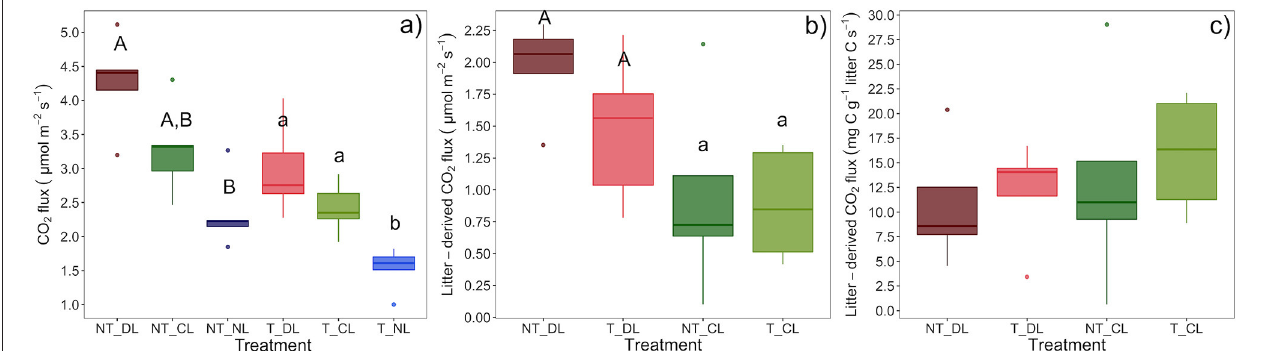
FIGURE 8 | (a) Mean CO 2 flux, (b) CO 2 flux excess associated to the leaf litter inputs taking the No-Litter treatment as a baseline in each of the trenching and leaf litter input treatments and (c) CO 2 flux excess associated to the leaf litter inputs per unit of leaf litter carbon. Box-plots represent the values of n = 5 plots